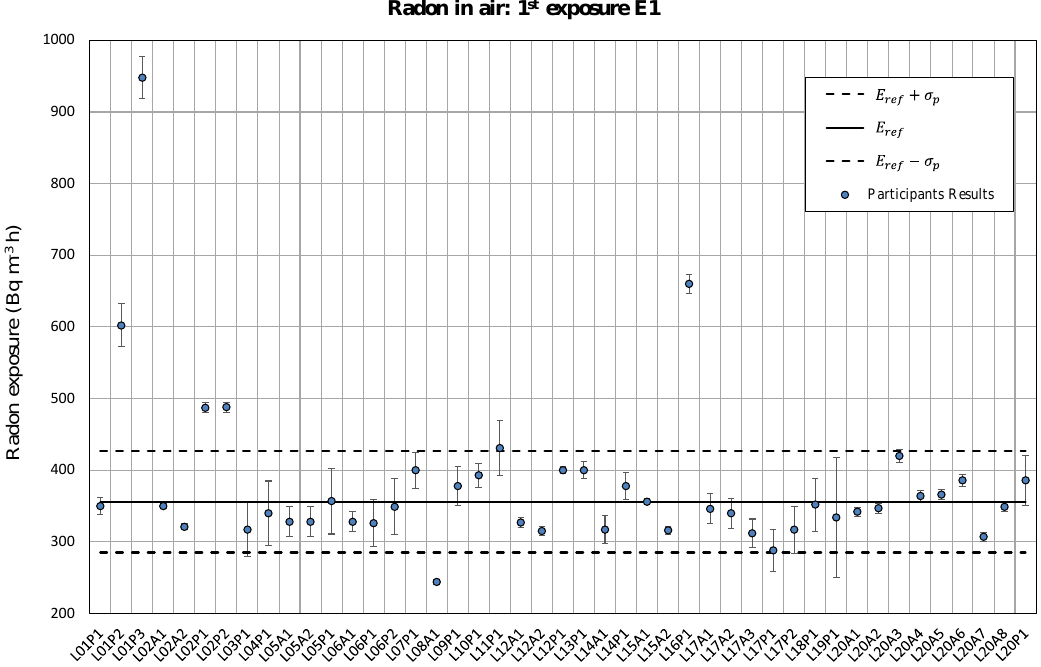
Figure 5. Participant’s results for the first exposure E1 with its associated uncertainty ( k = 1). The exposure reference value is shown with a solid line and the standard deviation σ p = 0.2 E ref with dashed lines.